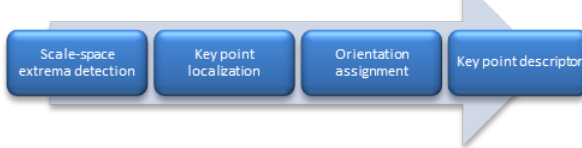
Figure 3. Schematization of the functioning of SIFT (Scale Invariant Feature Transform).